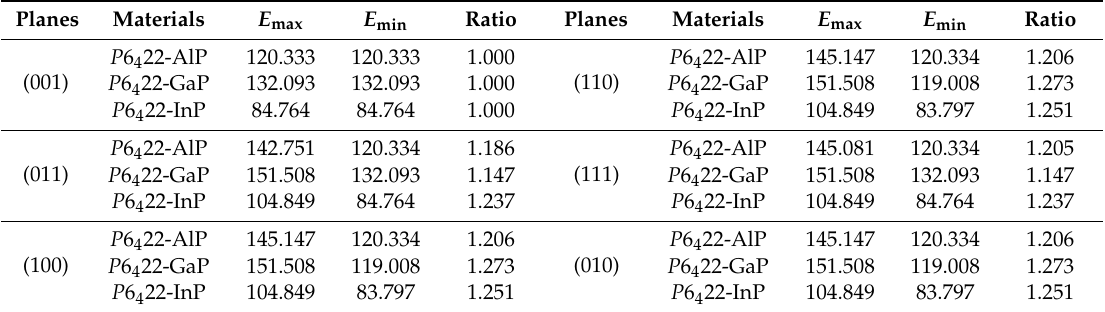
Table 3. The calculated maximum values E max , minimum values E min and ratios E max / E min of X P ( X = Al, Ga, or In) in the P 6 4 22 phase via the method of